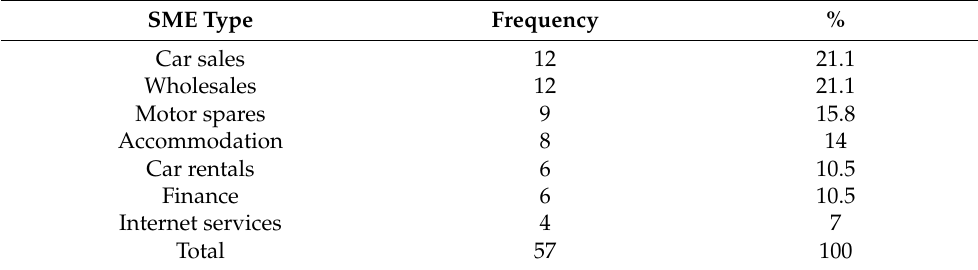
Table 2. Distribution of surveyed SMEs by